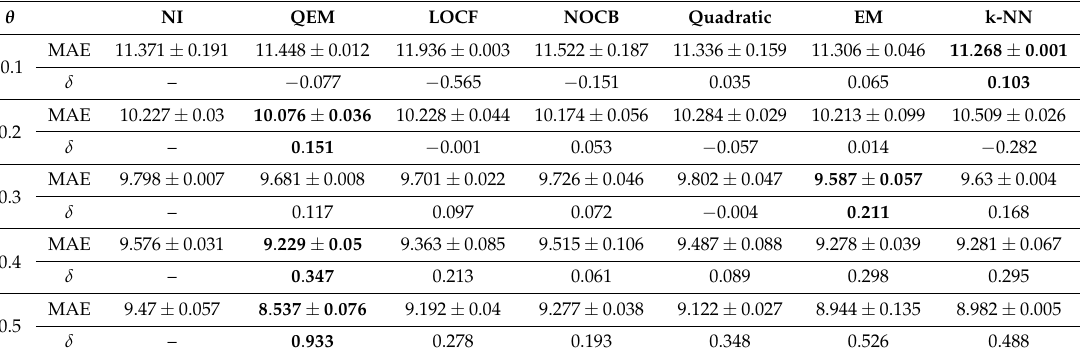
Table 5. Summary of the performance